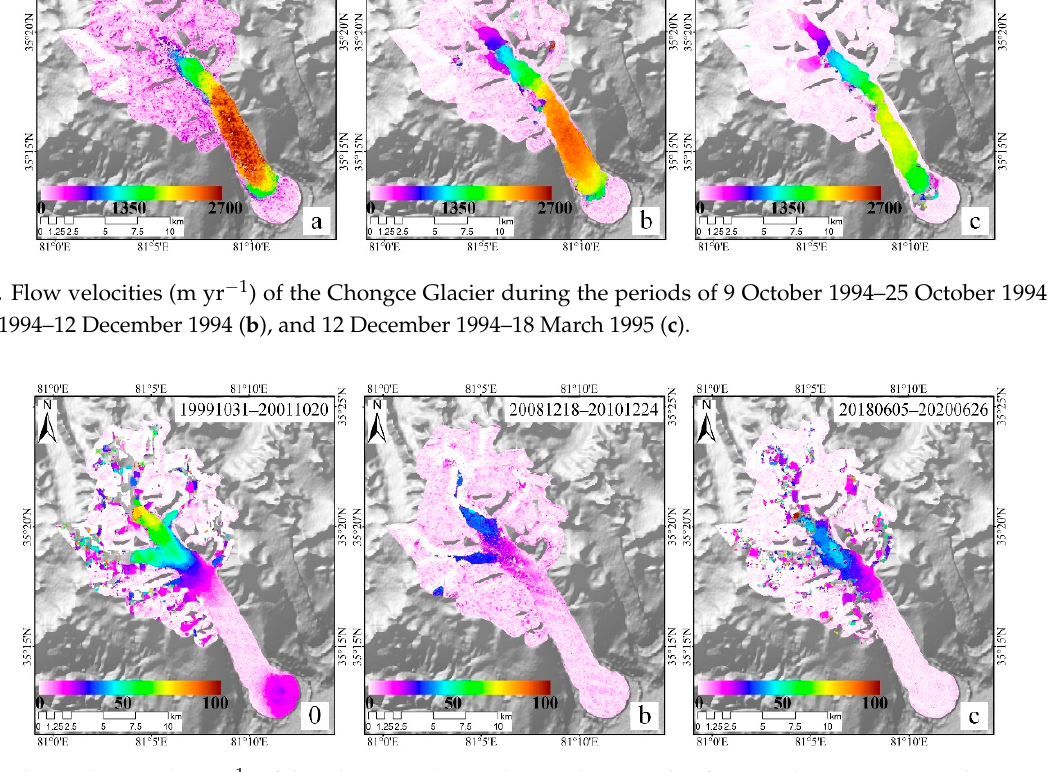
Figure 5. Flow velocities (m yr − 1 ) of the Chongce Glacier during the periods of 31 October 1999–20 October 2001 ( a ),